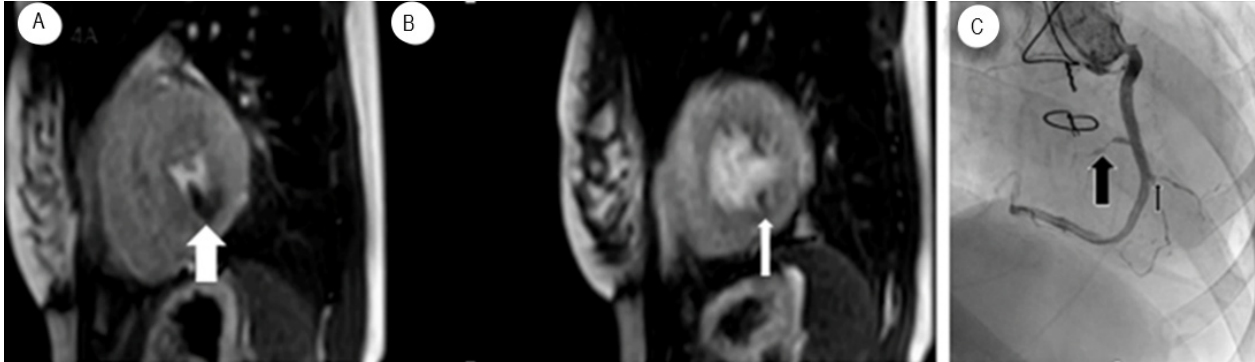
Figure 5. ( A , B ) MRI Perfusion images showing inferior ischemia induced by Adenosine (white arrow) in a patient with known CAV ( C ) Black arrows showing stenosis on selective coronary angiogram.